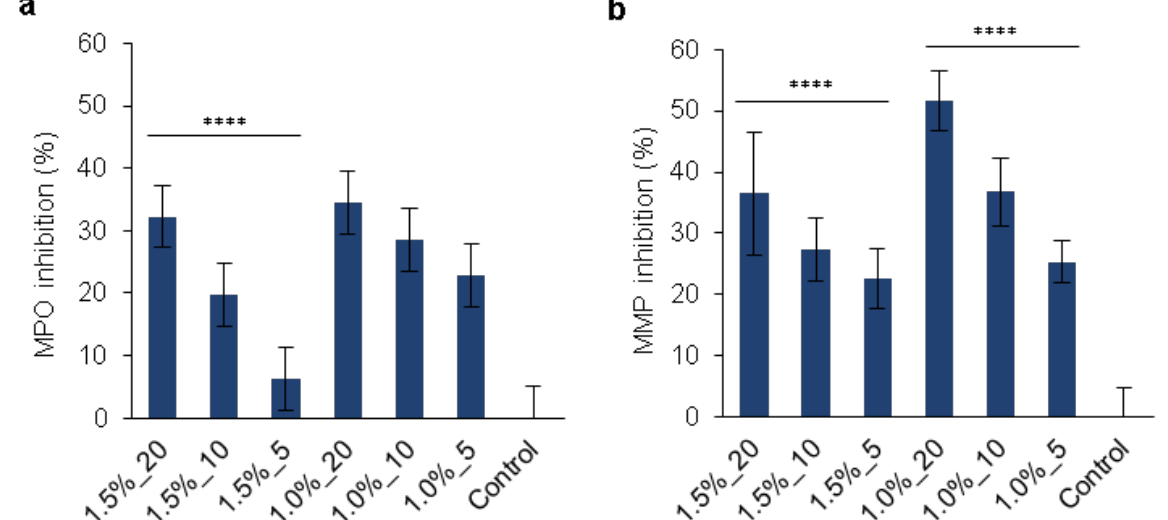
Figure 6. In vitro ( a ) MPO and ( b ) MMPs inhibition (%) by the hydrogels. Results are expressed in percentages of enzyme inhibition relative to the control (enzyme without hydrogel). Results are reported as mean values of enzyme inhibition (%) (n = 4) ± SD. A one-way ANOVA analysis was used to confirm the difference in MPO and MMP inhibition capacities among the different hydrogel formulations ( p value < 0.0001 is indicated as ****).